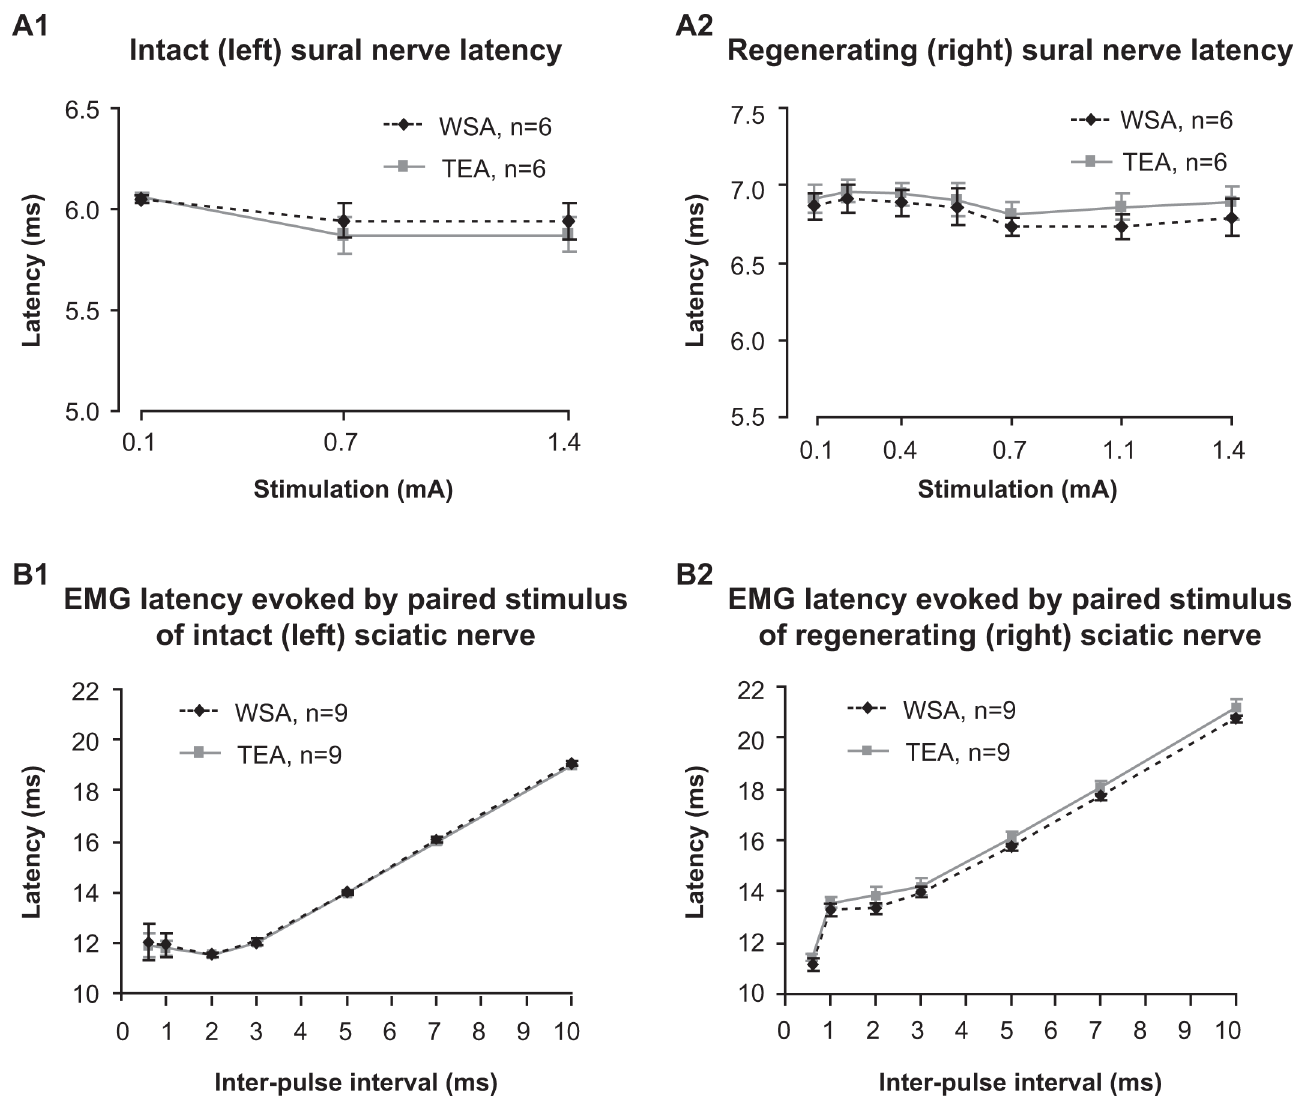
Fig 6. Latency profiles derived by WSA and TEA. The latency to the peak of the first event of N10avRs (A1, intact side; A2, regenerating side) and the latency to the peak of M5avRs (B1, intact side; B2, regenerating side) were measured using the temporal location of best fit between the event and its respective template signals (WSA), and compared with the latency of the peak of each respective event (TEA). There was no significant difference in the latencies derived from WSA and TEA. Inter-pulse interval = time interval between the conditioning and testing pulses (refer to Fig 4). Abbreviations: WSA, waveform similarity analysis; TEA, trained eye